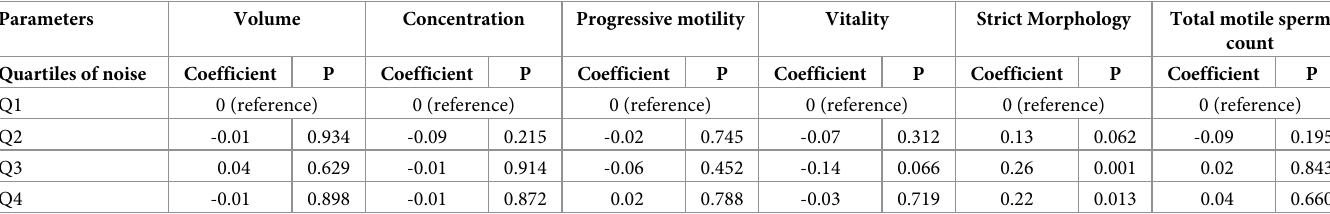
Table 2. Adjusted regression coefficient of environmental noise (Leq dB (A)) for six continuous semen quality parameters a